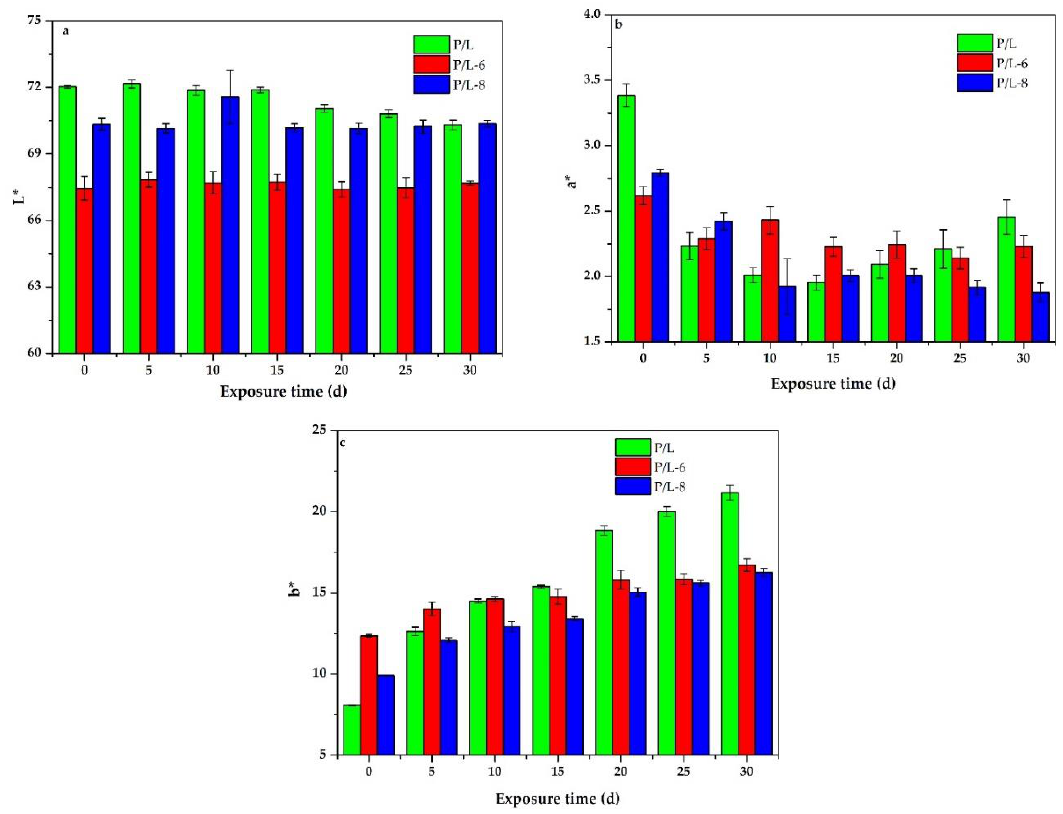
Figure 3. L *, a *, and b * values of samples before and after accelerated aging: ( a ) L *; ( b ) a *; and ( c ) b *. Table 2. Colors of samples before and after accelerated aging.